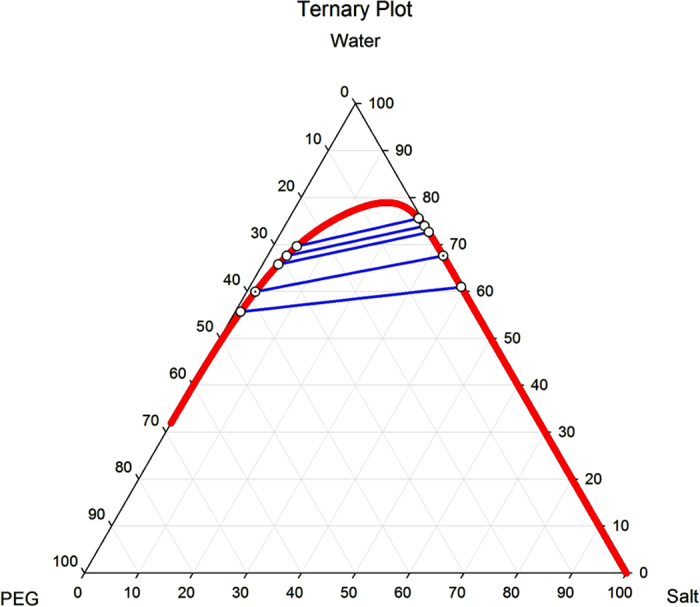
Biphasic diagram of different ATPSs; PEG6000+MgSO4 offers the widest extent.